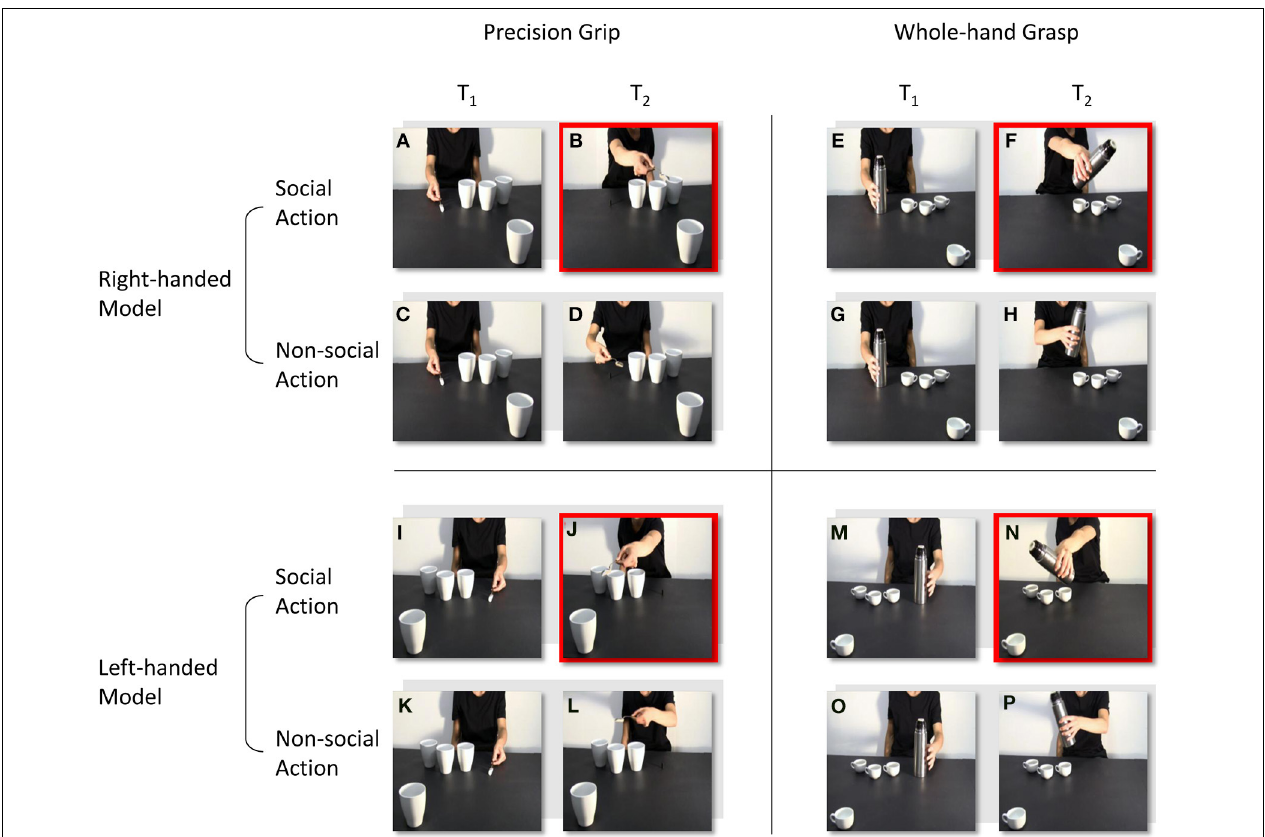
FIGURE 1 | Frames extracted from the video-clips at the time-points at which TMS pulses were delivered (T 1 and T 2 ). A right-handed actor reaches and grasp a sugar spoon (A) , then she stretches out her arm trying to pour some sugar on a cup located out of her reach (B) . The actor reaches and grasp the same sugar spoon (C) , but then she takes it back to the starting position (D) . The actor reaches and grasp a thermos (E) , then she stretches out her arm trying to pour some coffee on a coffee cup located out of her reach (F) . The